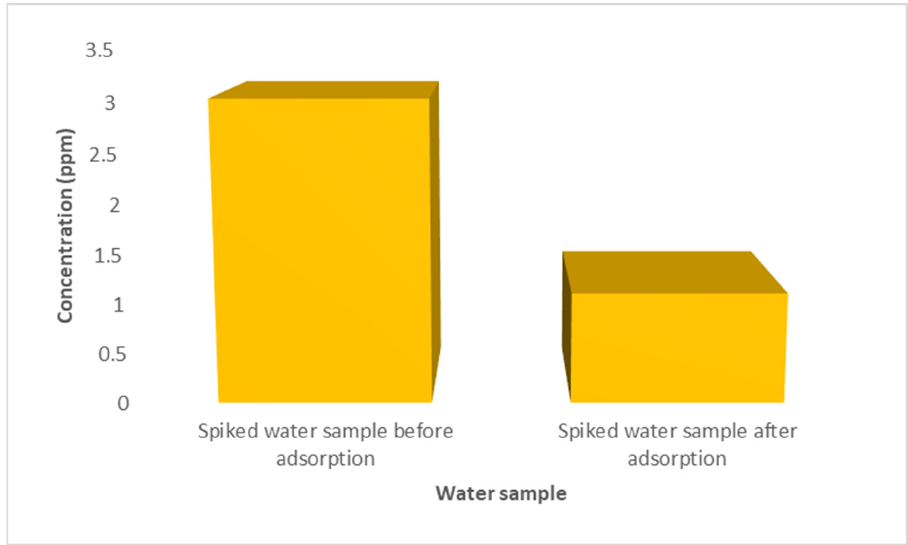
Figure 15. Tap water spiked with 3 ppm cadmium standard .